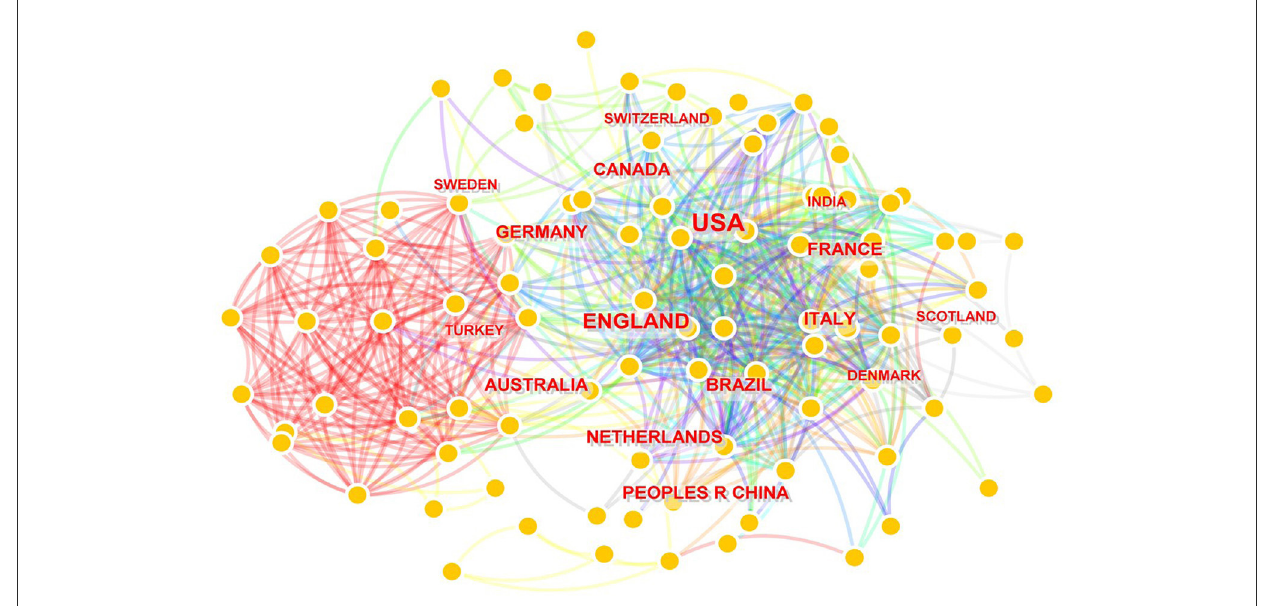
FIGURE3 Network map of countries engaged in SUDEP research.